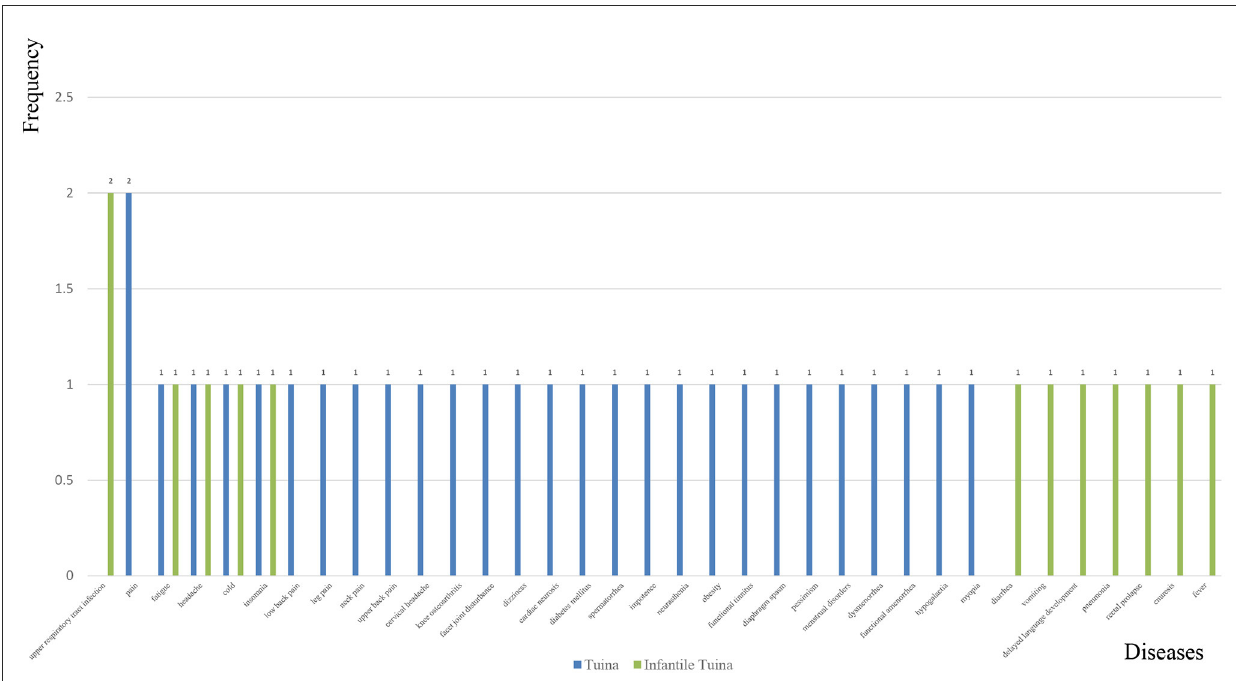
FIGURE2 Names of diseases included in the literature (abscissa axis) and their frequency (ordinate axis).